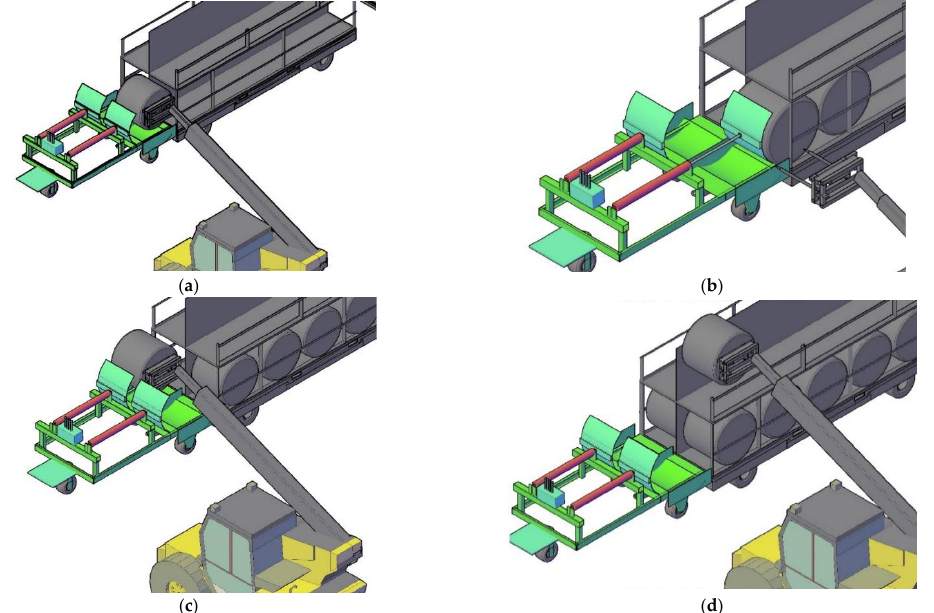
Figure 5. ( a ) Telehandler placing bale into bale loader used to load bales into bottom tier chamber of rack, ( b ) Bale loader shown inserting a second bale into the bottom tier chamber of rack. ( c ) Filling back lower-tier chamber. ( d ) Concept for telehandler loading bales in top tier chambers.